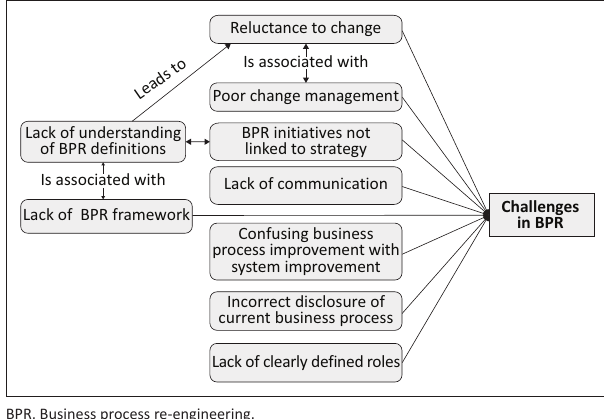
FIGURE 2: Business process re-engineering